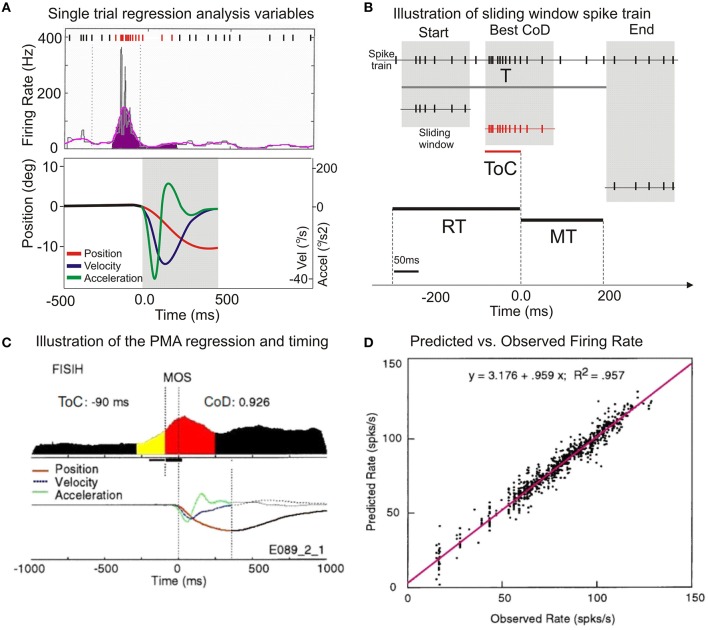
Illustration of the application of multilinear regression analysis. (A) A single trial histogram of the neuronal activity expressed as mean firing rate (in spikes/s), together with the kinematic variables of position, velocity, and accelaration. (B) Illustration of the sliding window regression analysis. RT, reaction time; MT, movement time; ToC is the time of best correlation (at best CoD). (C) A typical putamen neuron with increased premovement activity during vibratory cued trials is shown. The display of the average kinematics for uncertain reward flexion trials R, are centered on MOS, on both panels. (D) The scatter diagram of the predicted discharge rate plotted against the observed rate. Regression equation of predicted vs. observed mean firing rates and the regression coefficient in the upper part of the panel.